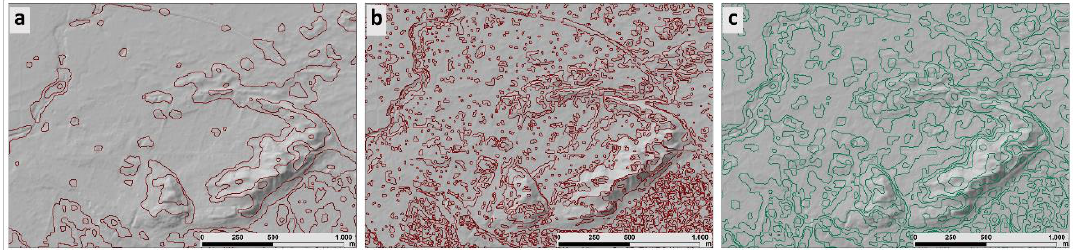
Figure 6. Study area segmentation at different scale parameters; 5: too large ( a ), 20: too small ( b ), 10: good result ( c ). The background for the segmentation is the LiDAR-DEM with the resolution of 1 m.